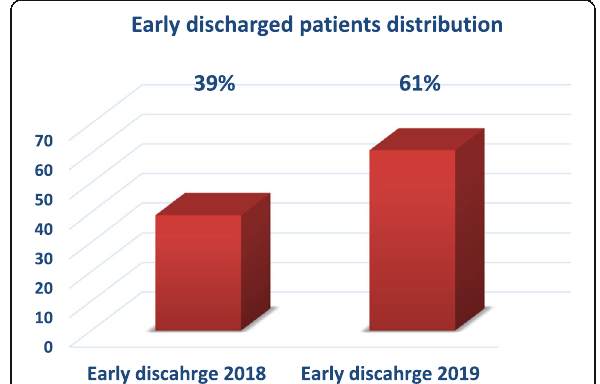
Fig. 2 Early discharged patients distribution in hajj seasons 2018 and